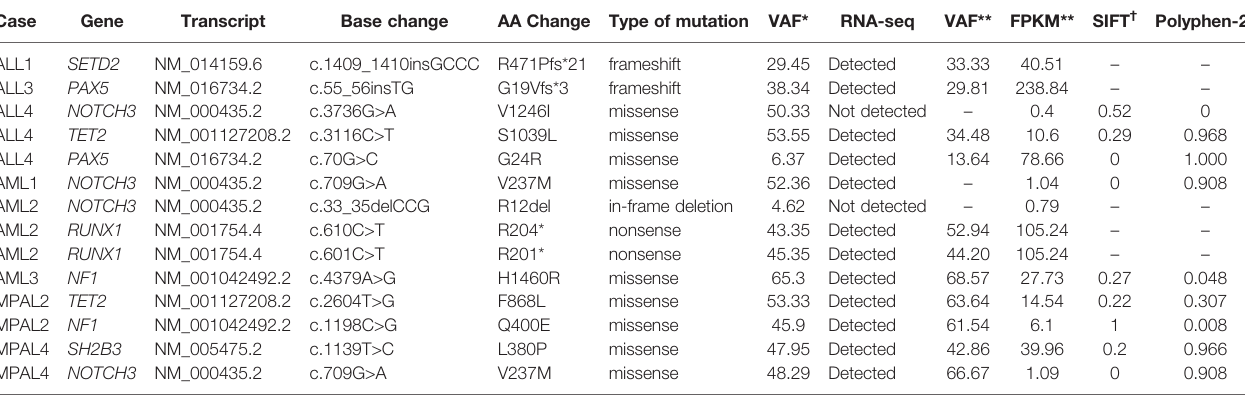
RNA-seq detected most variants detected in DNA sequencing except two with low gene expression value as FPKM < 1.0. AA, amino acid; VAF, percentage of variant allele frequency; RNA-seq, RNA sequencing; FPKM, Fragment Per Kilobase of transcript per Million mapped reads; SIFT, Sorting Intolerant From Tolerant. *VAF obtained from massive parallel sequencing of DNA. **VAF and FPKM obtained from RNA-seq. † The SIFT and Polyphen2 in-silico scores are unavailable for frameshift and nonsense mutations and in-frame